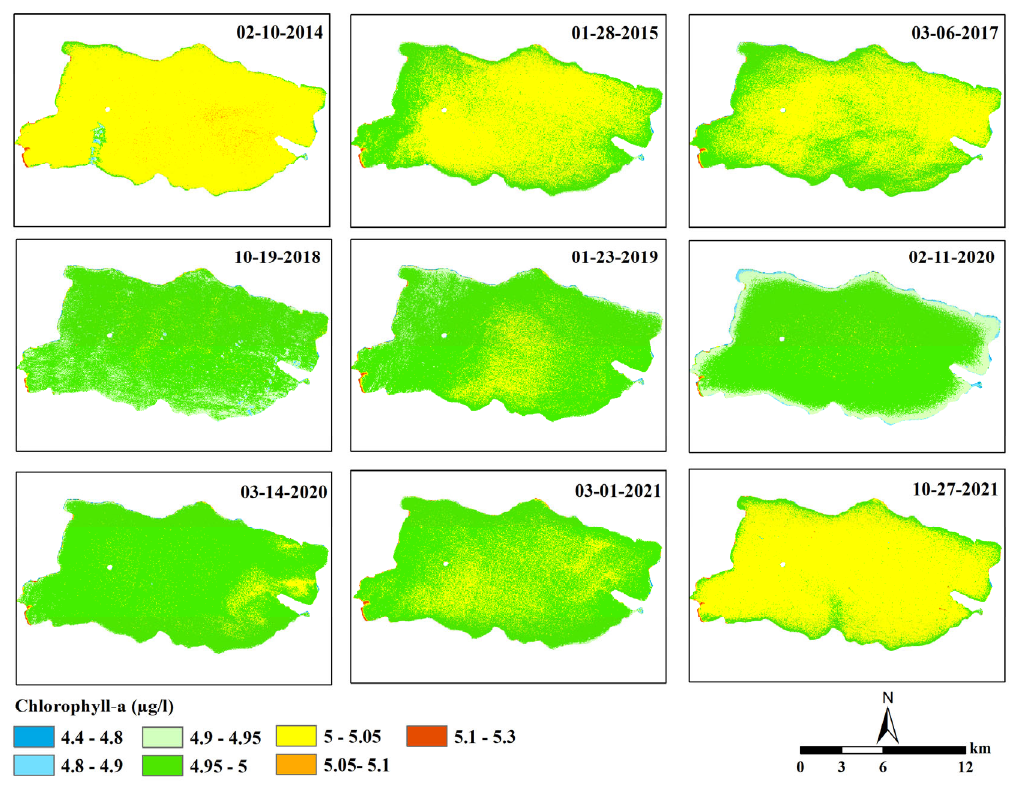
Figure 5. Spatial pattern of Chlorophyll-a arising from multivariate regression resulting from spectral indices through as seen Landsat